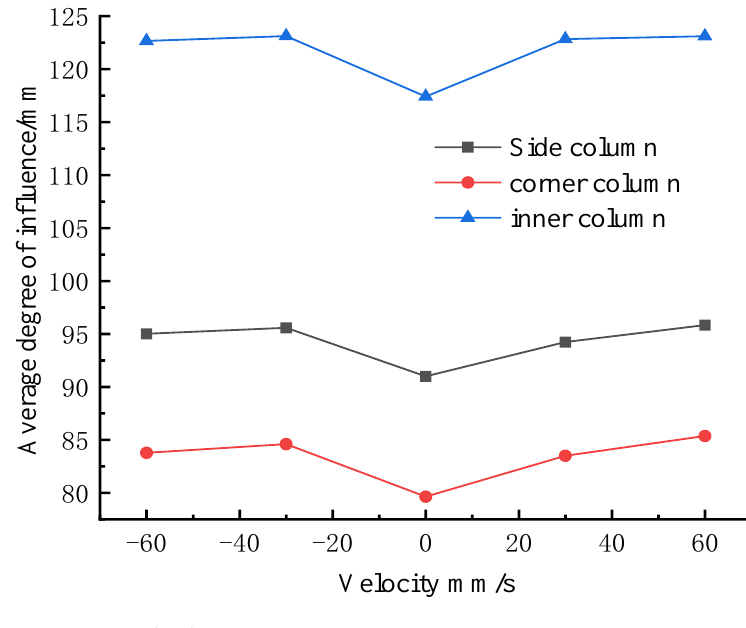
Figure 8. Initial velocity .